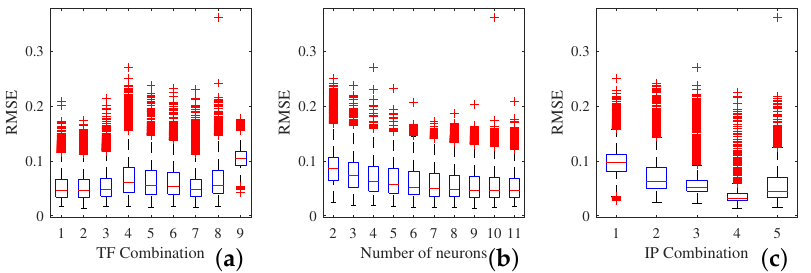
Figure 7. Influence on the performance of the ANNs by: ( a ) The transfer function (TF); ( b ) the number of neurons; and ( c ) the input parameter (IP)